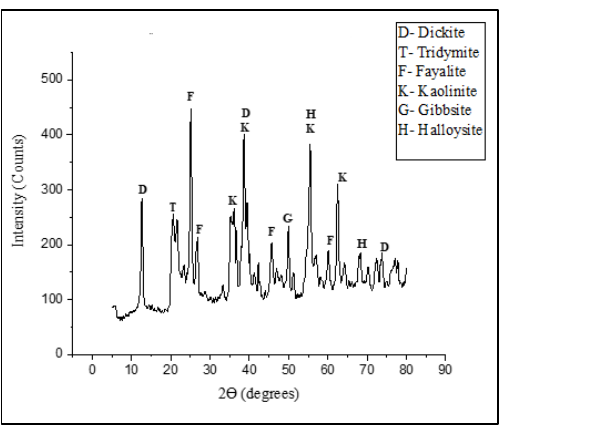
Figure 19. EDS analysis of Nagoor sample; ( a ) elements weight (%), ( b ) atomic weight (%), ( c ) SEM image, ( d ) spectrum image.